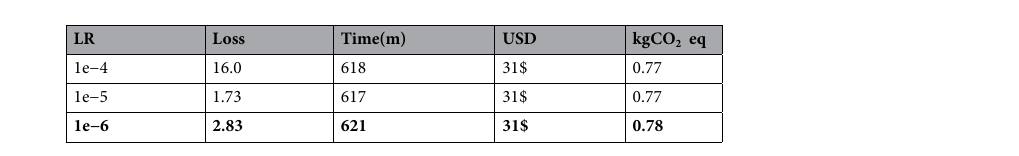
Table 5. Comparing training time, performance, costs, and carbon emission on variants of the FashionCLIP architecture on the Farfetch catalog. Cost is calculated with the AWS pricing for a p3.2xlarge ; estimations were conducted using the Machine Learning Impact calculator 84 . Model used for testing in bold.